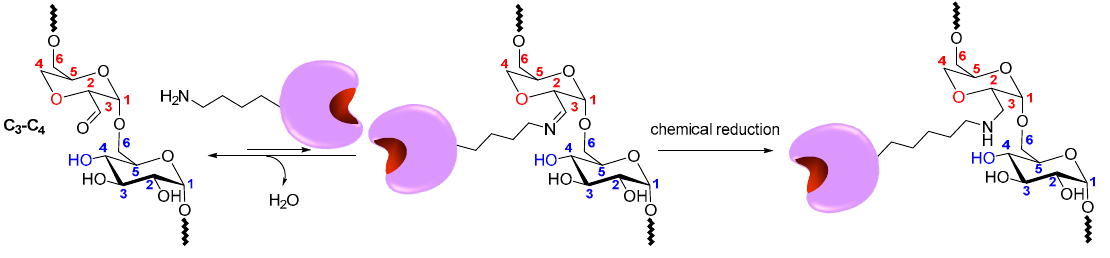
Figure 6. Coupling of dexOx with proteins via reductive amination.